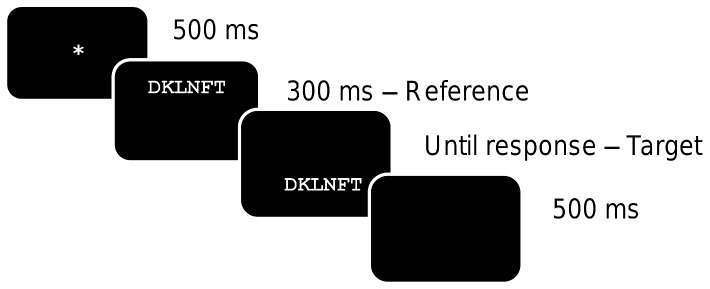
Shematic representation of an experimental trial.